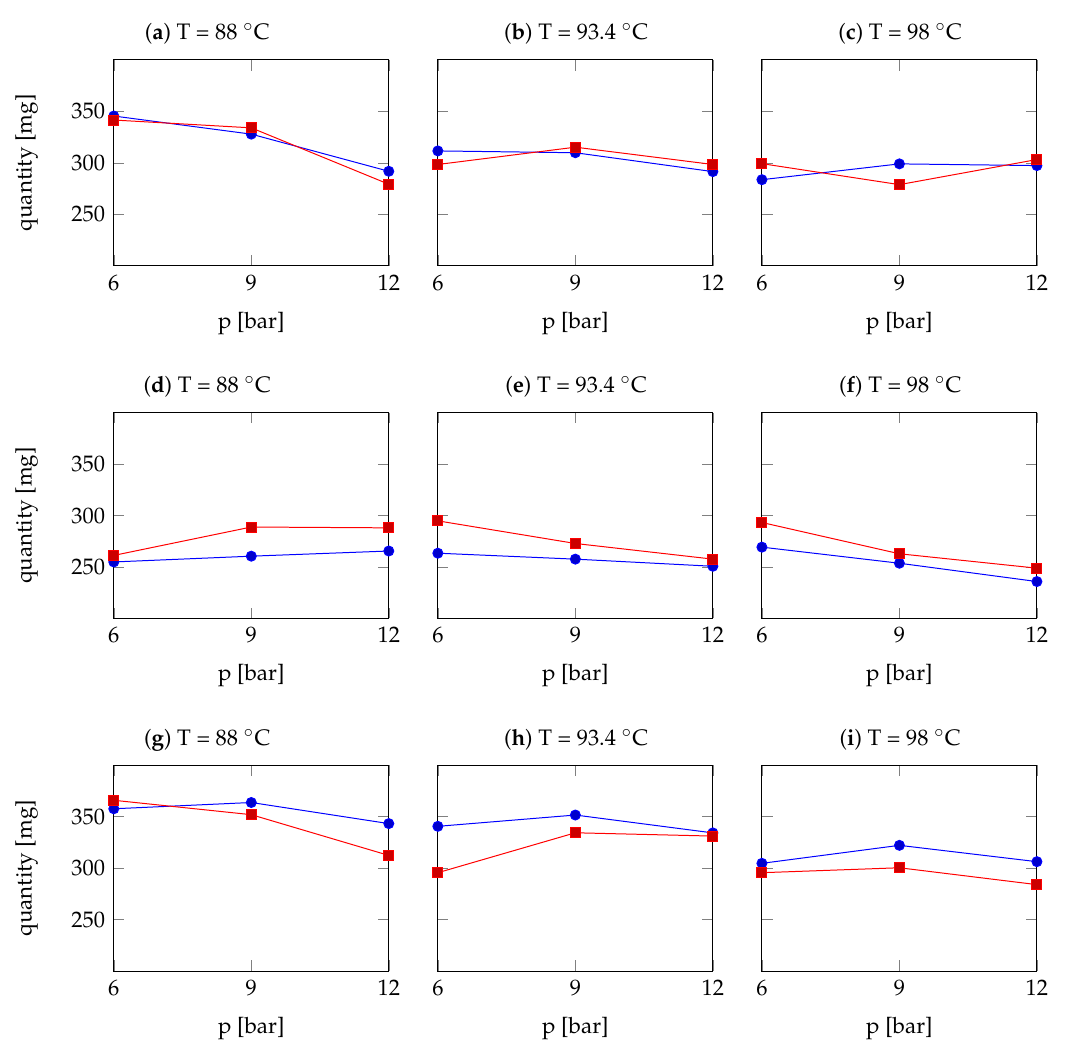
Figure 11. Comparison between the caffeine extracted through numerical simulations (blue profile with circles) and laboratory measurements (red profile with squares), with different inlet water temperatures and pressures and different grain size of Robusta coffee powder. Figures ( a – c ) show the results of optimal granulometry, Figures ( d – f ) of coarse granulometry and Figures ( g – i ) of fine